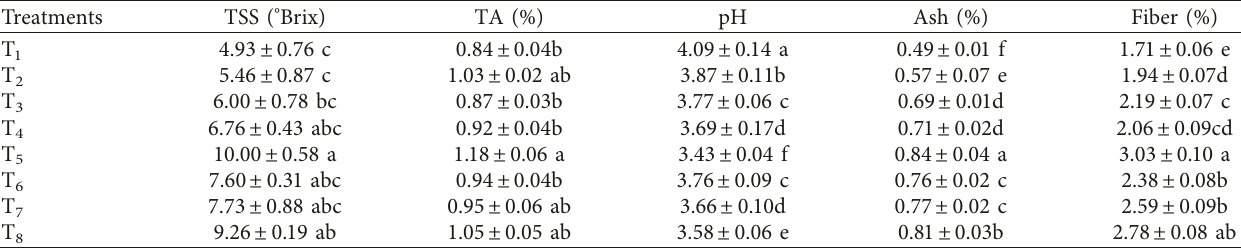
Table 3: Influence of different organic and inorganic fertilizer regimes on postharvest quality of strawberry cv. Chandler.